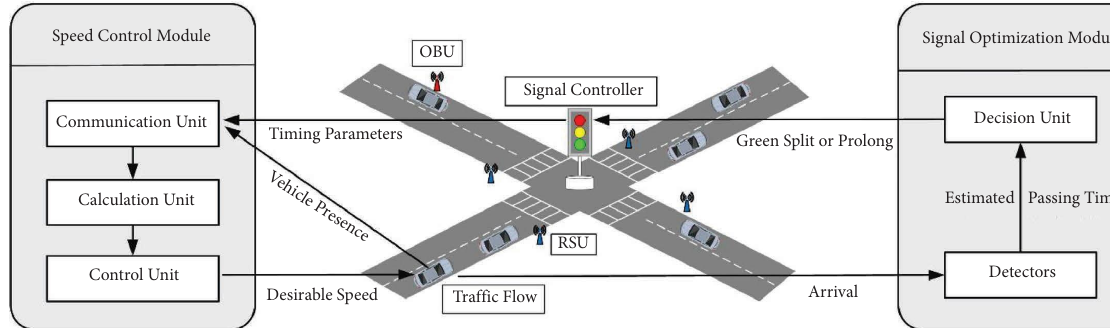
Figure 2: Framework of